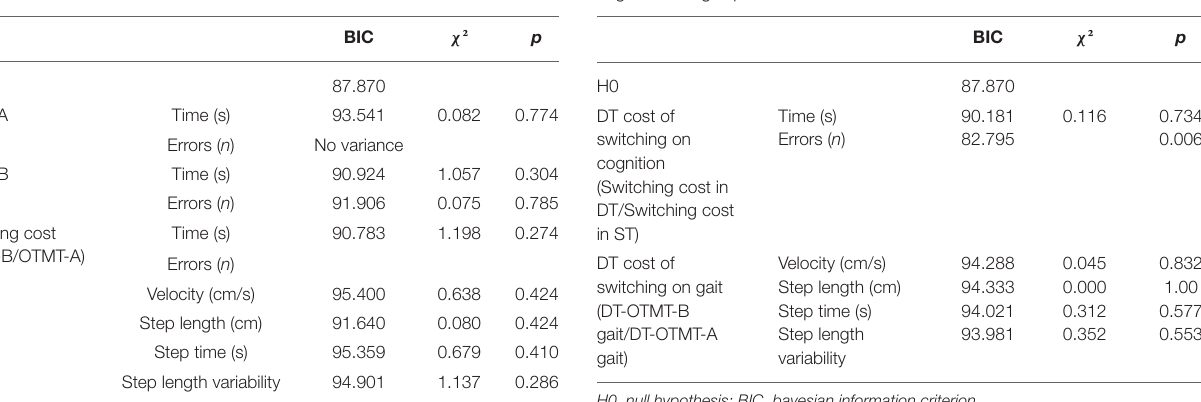
TABLE 6 | Characteristics of the logistic regression model of DT costs on cognitive and gait